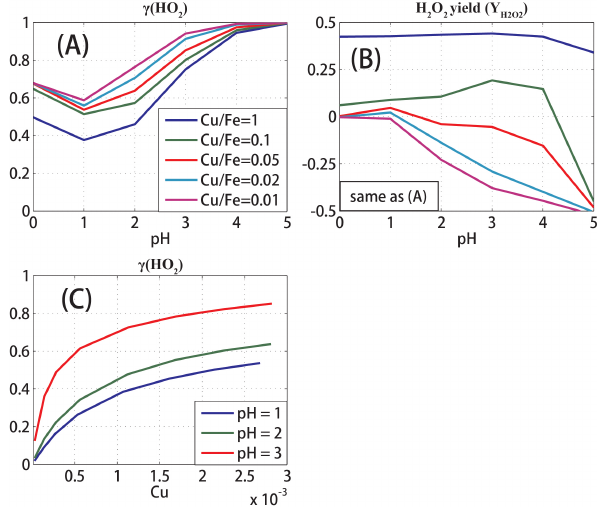
Fig. 3. Impacts of Cu-Fe-HO x cycling on aerosol chemistry for the model calculations described in the text. (A) and (B) : pH dependence of the HO 2 reactive uptake probability γ (HO 2 ) and the corresponding H 2 O 2 yield for a dissolved Cu concentration of 2,9 × 10 − 3 M and different Cu/Fe molar ratios. (C) : depen- dence of γ (HO 2 ) on Cu concentrations for different pH values with